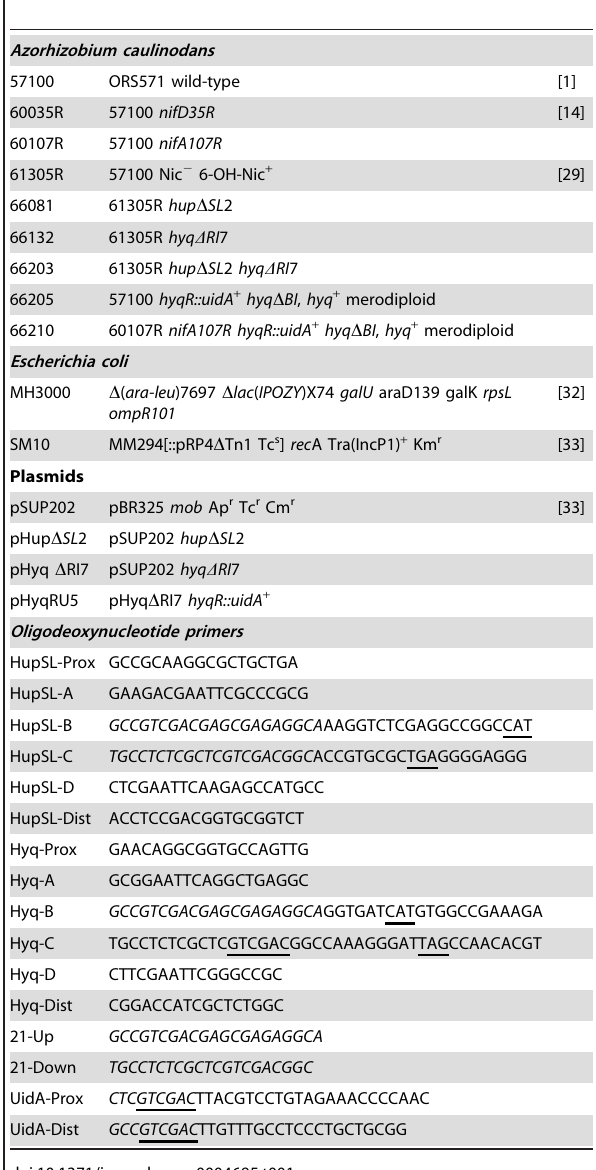
Table 1. Bacterial strains and oligodeoxynucleotide primers